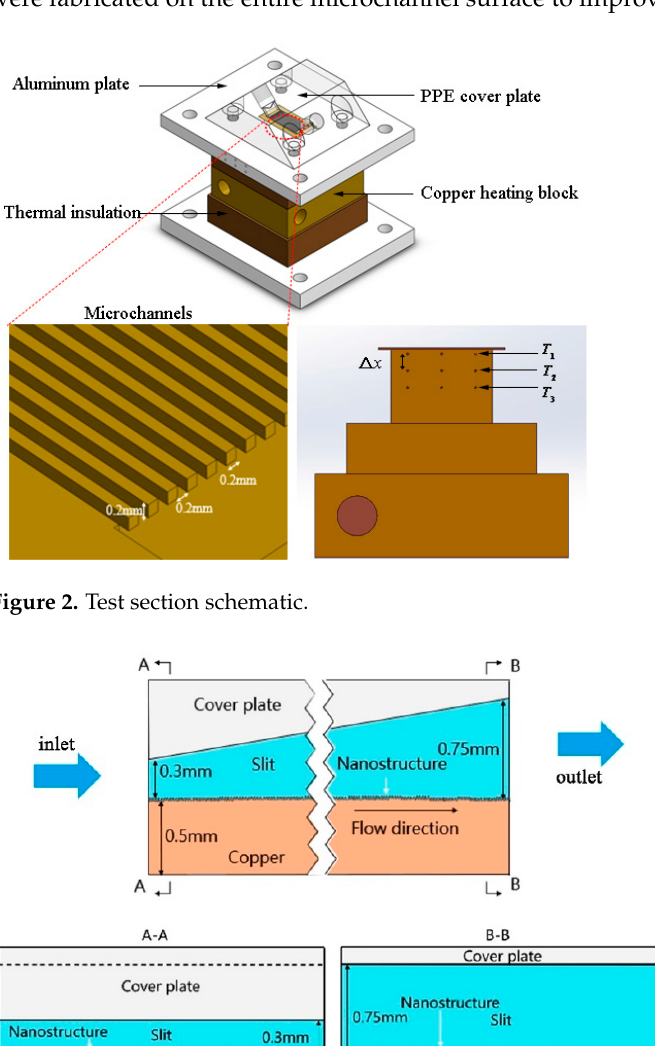
Figure 1. Experimental system schematic.